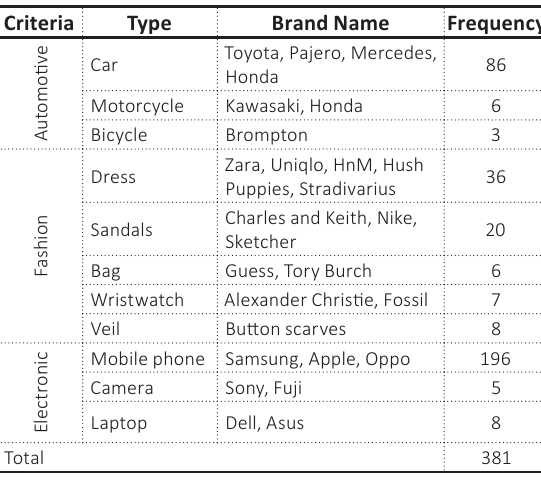
Table 2. Types and brands of